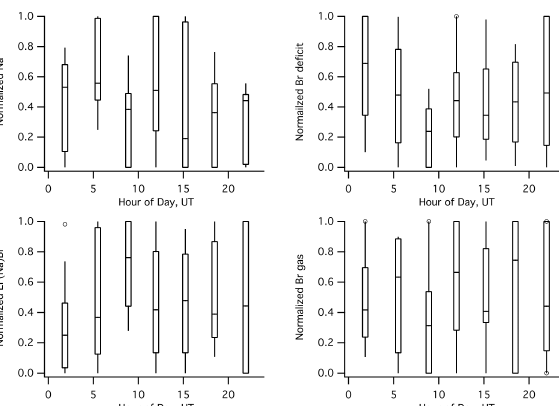
Figure 9. Box-and-whisker plots of the diel variability of normal- ized Na and Br data. In these plots the daily maximum concentration was set to 1 and the minimum concentration was set to 0. The solid line near the middle of each box represents the median. The bot- tom of the box represents the 25th percentile and the top of the box represents the 75th percentile. The whisker ends mark the 10th and 90th percentiles. Outliers are displayed for values below the 1st or above the 99th